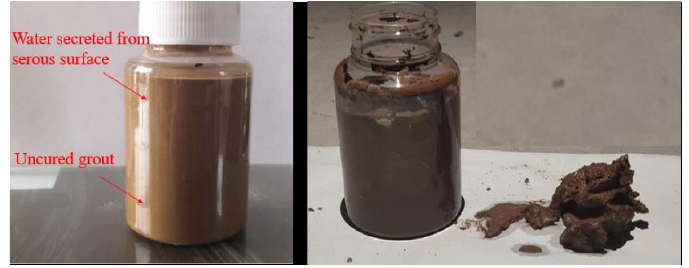
Figure 4. Clay cement slurry does not solidify after standing for half a